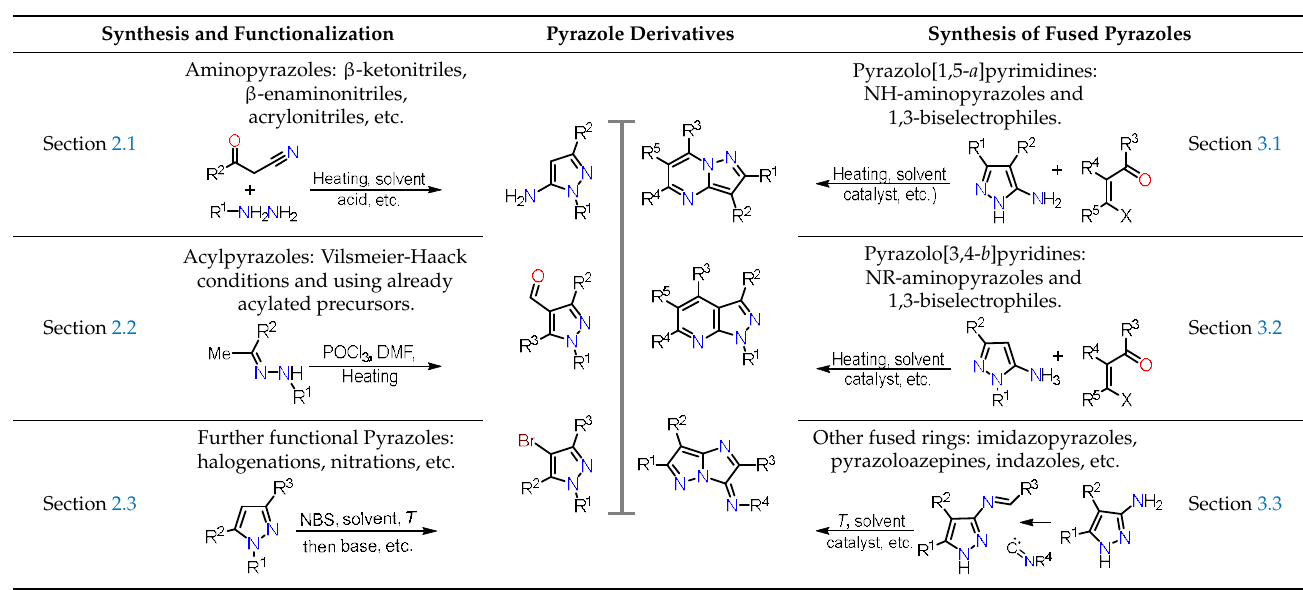
Table 1. Overview of synthesis of pyrazole derivatives [a] .